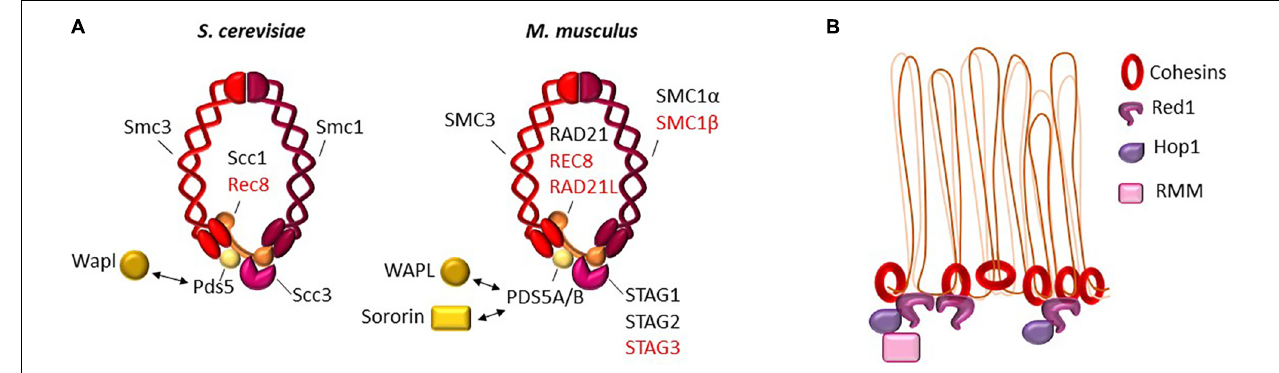
FIGURE 2 | (A) The cohesin complex. Schematic presentation of the ring-like structure of the cohesin complex (red, pink, and orange), and the main regulators of its stability (yellow) in S. cerevisiae (left) and in mouse (right). Sororin-Pds5 interaction promotes stabilization of the cohesin complex and Wapl-Pds5 interaction promotes unloading of the cohesin complex. During meiosis in S. cerevisiae , the somatic α -kleisin subunit Scc1 (also called Rad21) is replaced by Rec8 (red). In mouse, several meiosis specific subunits exist (indicated in red), and differently combined lead to various cohesin complexes. Constitutive and meiotic orthologs of the various subunits are also listed in Table 1 . (B) 2D localization of the cohesin complex and main partners in S. cerevisiae. In S. cerevisiae , cohesins and its main meiotic partners localize at axial elements at the basis of chromatin loops, where they contribute to loop-axis formation and sister chromatid cohesion. RMM is